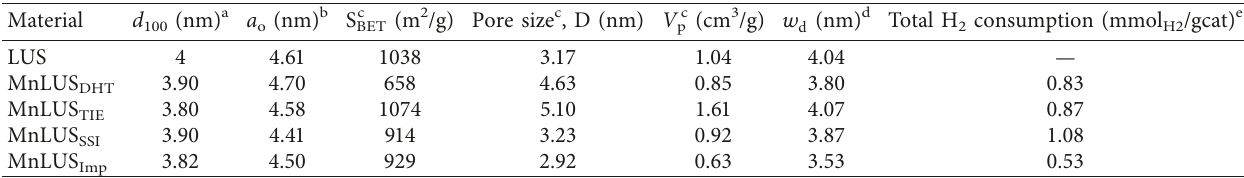
Figure 1: XRD patterns (a) at low diffraction angles of (A) LUS and MnLUS (7 wt.%), (B) MnLUS SSI , (C) MnLUS TIE , (D) MnLUS DHT , and (E) MnLUS Imp and (b) at high diffraction angles of (A) LUS, (B) MnLUS TIE , (C) MnLUS DHT , (D) MnLUS Imp , and (E) MnLUS SSI . Table 1: Physicochemical characterization of MnLUS catalysts.